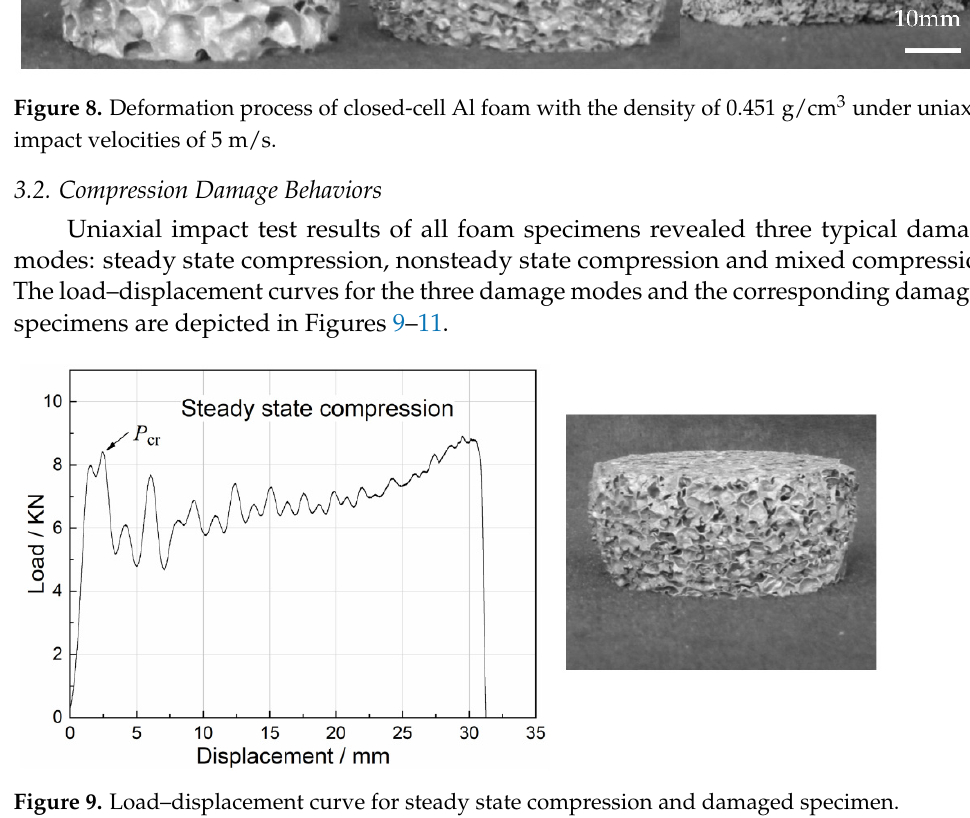
Figure 8. Deformation process of closed-cell Al foam with the density of 0.451 g/cm 3 under uniaxial impact velocities of 5 m/s.